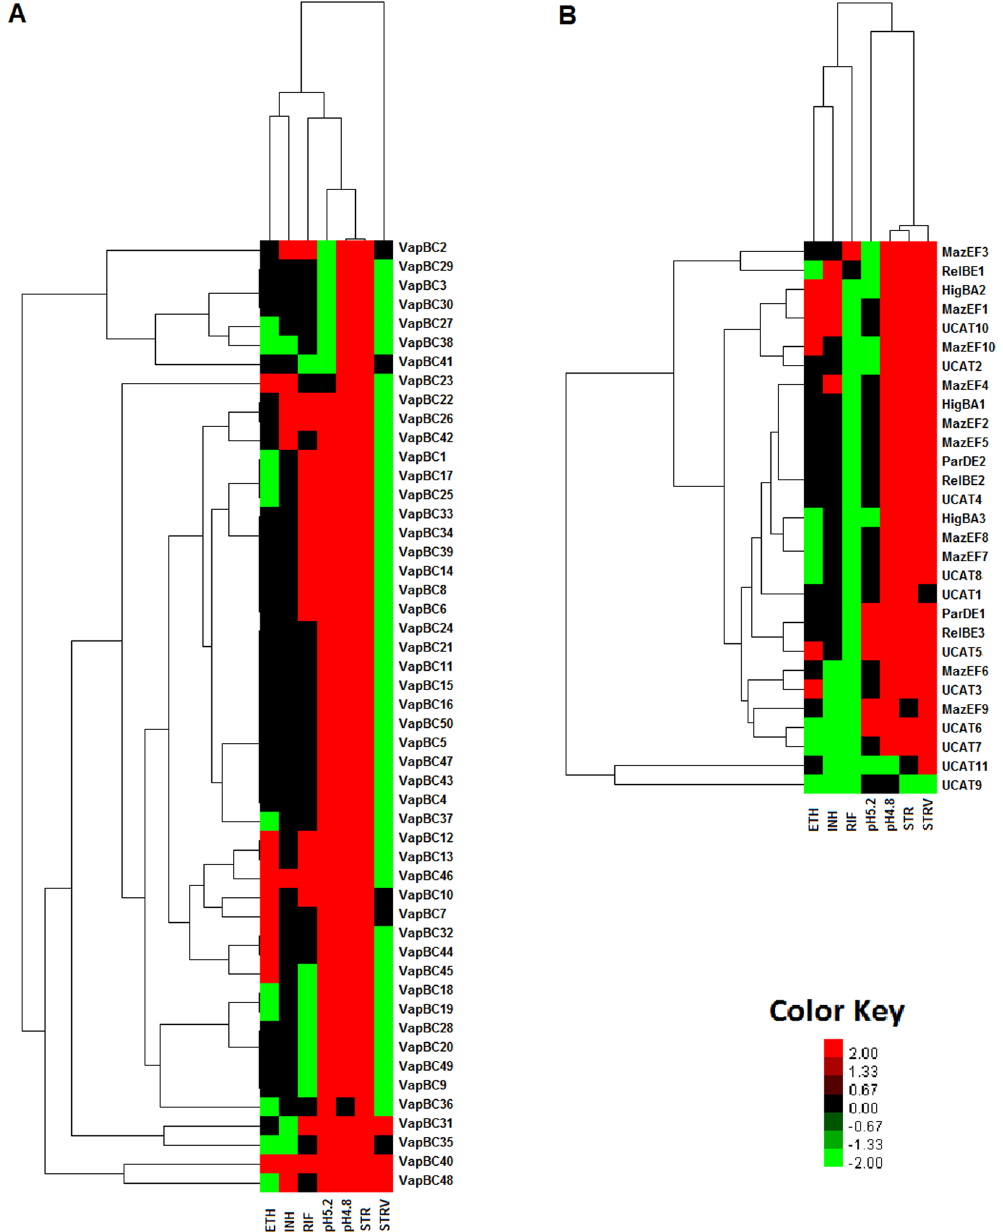
Figure 6. Unsupervised hierarchical clustering analysis of TA loci based on their activation and deactivation status in response to stress. All the 79 TA loci with their activation-deactivation and co-expression status defined as 2 for activation, − 2 for deactivation and 0 for co-expression were subjected to unsupervised hierarchical clustering using Cluster 3.0 software by applying Pearson Uncentered algorithm with average linkage rule. The resultant cluster file was imported into Java Treeview software to visualize the cluster. Activated TA loci are in red color gradient and Deactivated TA loci are in green color gradient. A score of 2 was given as a cutoff to render the cluster image to identify patterns of activation and deactivation of TA loci across conditions